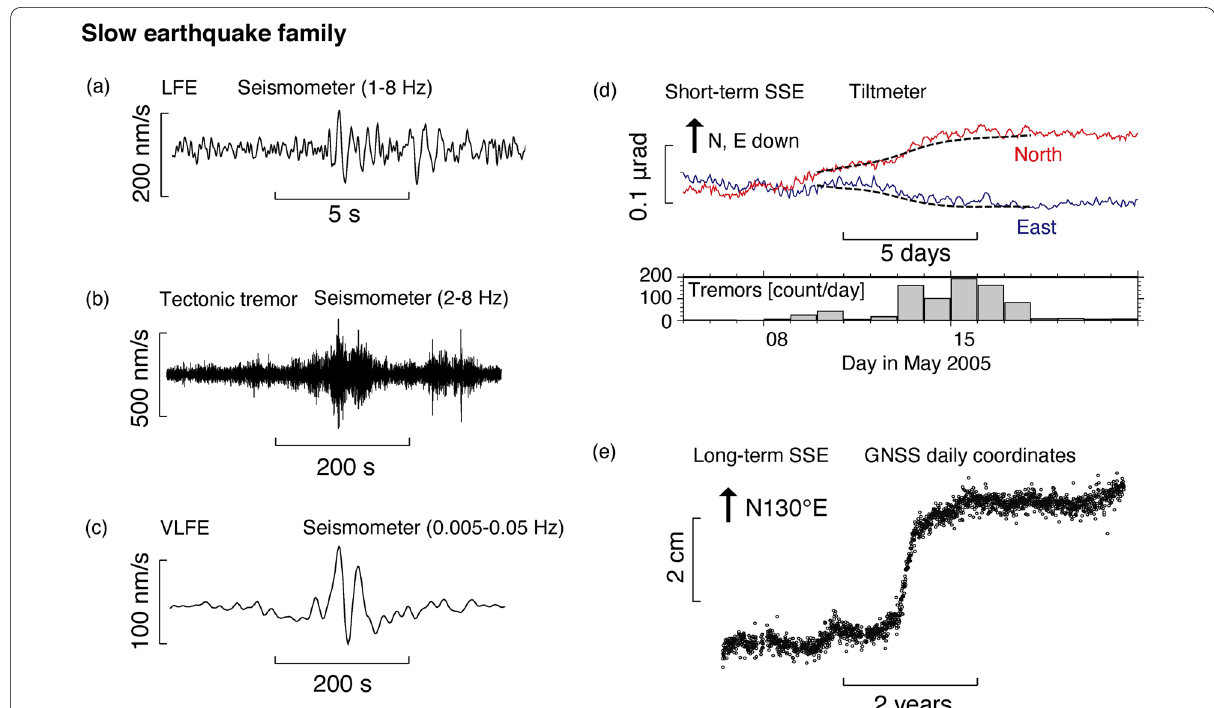
Fig. 2 Observed signals of the slow earthquake family. The slow earthquake family includes a low-frequency earthquakes (LFEs) (Shelly et al. 2007), b tectonic tremors (Ide et al. 2008), c very-low-frequency earthquakes (VLFEs) (Ide et al. 2008), d short-term slow slip events (SSEs) (Hirose and Obara 2010), and e long-term SSEs (Takagi et al. 2016). In d the daily count of concurrent tectonic tremors is presented (Hirose and Obara 2010). The dashed lines in d indicate calculated tilt changes due to the short-term SSE (Hirose and Obara 2010). All the above signals of the slow earthquake family were observed on the deeper plate interface (25–40 km depth) of the Nankai Trough. GNSS, global navigation satellite